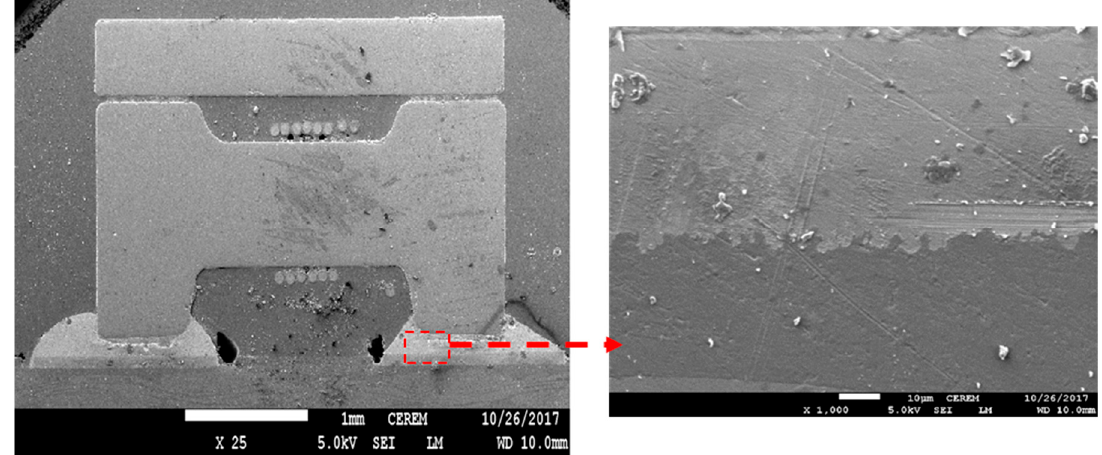
Figure 6. SEM micrograph for the joint interface of a passive component with SCAN solder paste.